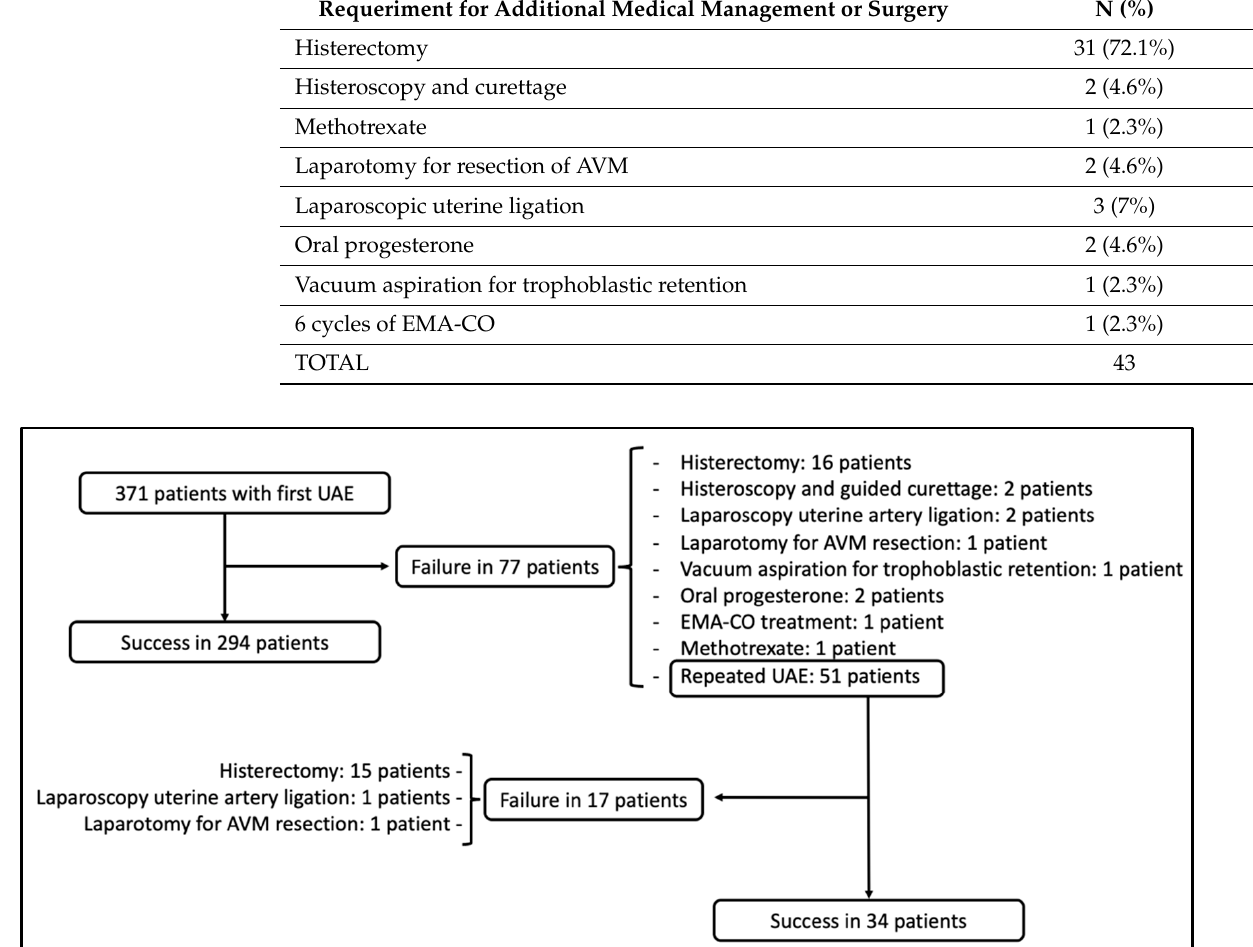
Figure 1. Flowchart to describe posterior management of first embolization procedure failure cases. Table 3. Global success rate after first and repeated embolization treatment.